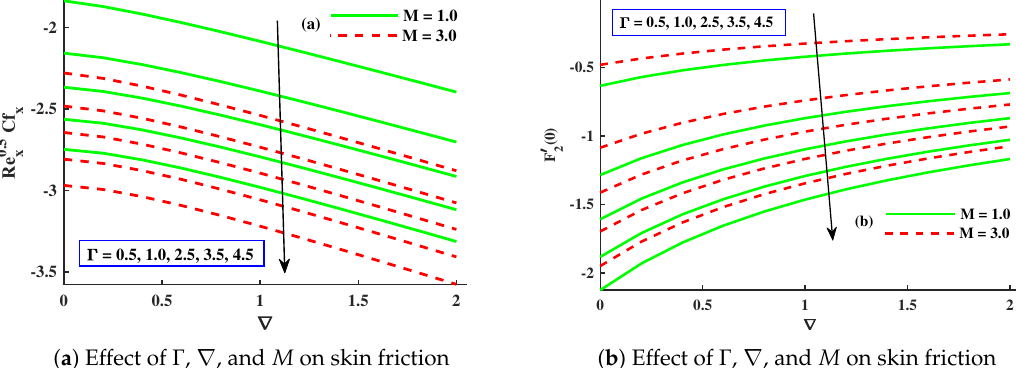
Figure 10. Curves of skin friction with ∇ , Γ , and M